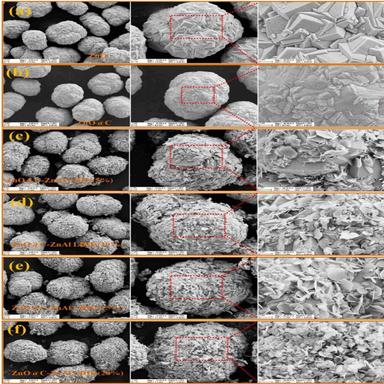
FE-SEM images of the as-prepared ZnO, ZnO@C, ZnO@C-ZnAl LDHs composites at different magnifications: (a) ZnO, (b) ZnO@C, (c) ZnO@C-ZnAl LDHs(5%), (d) ZnO@C-ZnAl LDHs(10%), (e) ZnO@C-ZnAl LDHs(15%), (f) ZnO@C-ZnAl LDHs(20%).